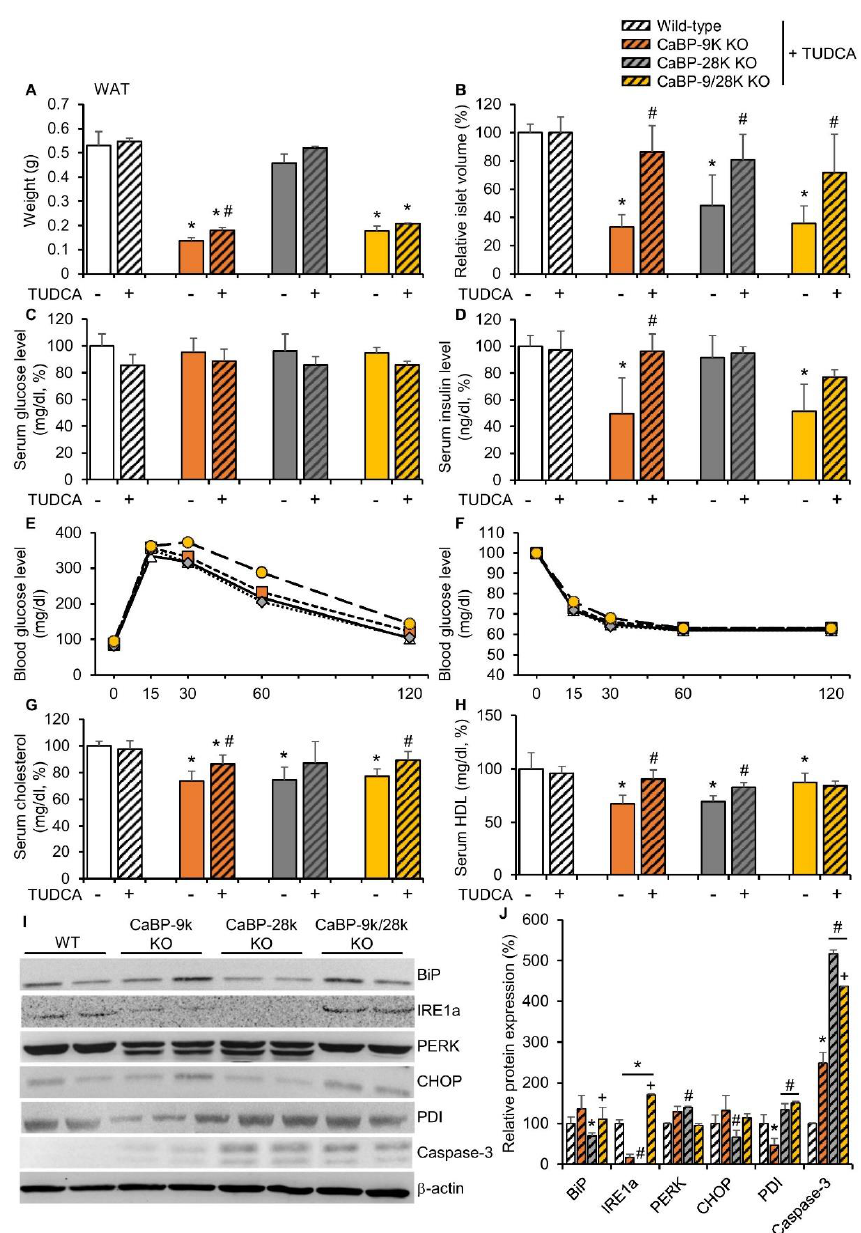
Figure 5. Tauroursodeoxycholic acid reduced CaBP-9k KO induced ER stress. TUDCA treatment recovered CaBP-9k deletion induced glucose tolerance and malregulation of lipid metabolism. The WAT mass ( A ), islet volume ( B ), serum glucose level at resting state ( C ), serum insulin level ( D ), glucose tolerance test ( E ), insulin tolerance test ( F ), serum cholesterol level ( G ), and serum HDL level ( H ) were recovered in response to TUDCA treatment. * p < 0.05 versus WT normal diet; # p < 0.05 versus normal diet in same mice genotype. ER stress marker protein expression in pancreas ( I , J ). Values are expressed means ± SDs; * p < 0.05 versus WT; # p < 0.05 versus CaBP-9k KO; + p < 0.05 versus CaBP-28k